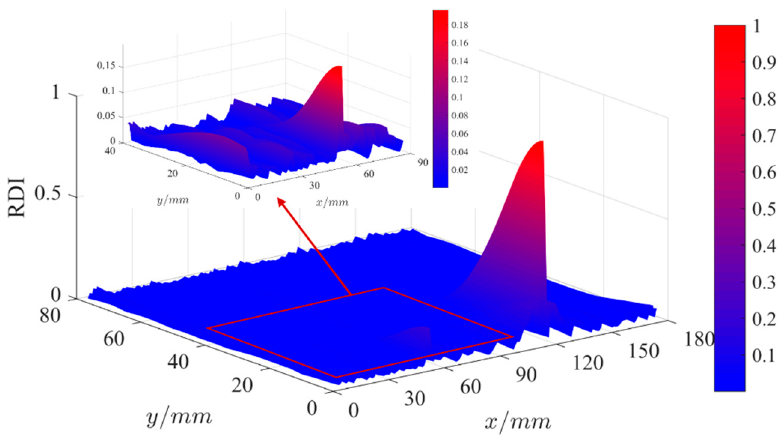
Figure 12. The RDIs surface plot of the second torsional mode in the y direction for the multi crack plate.